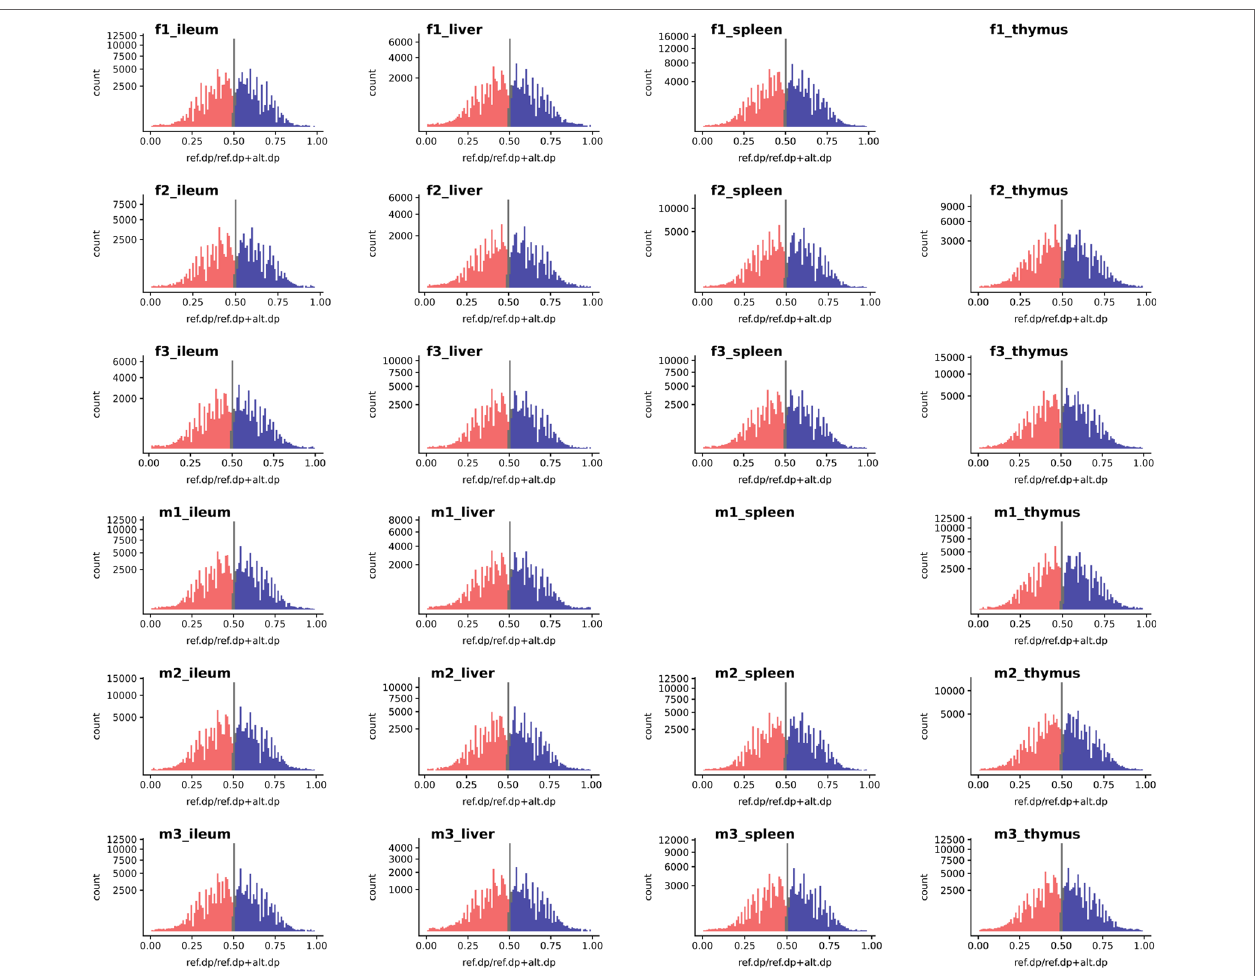
FIGURE 3 | The histogram of a global reference allelic ratio at every locus in the tissues. The distribution of ref allelic ratio showed a balanced profile without any 0 or 1 inflation which is observed in the presence of reference mapping bias. The allelic ratio above 0.51 is shown in blue and below 0.49 in red while balanced bi-allelic expression (0.49 – 0.51) is colored in gray. Ref.dp, read counts for reference allele; Alt.dp, read counts for alternate allele. The y axis is square root scaled. As discussed in the text SNP that display MAE are not present in any of the samples analyzed, indicating there was no inflation in either 0 or 1 allelic ratio.